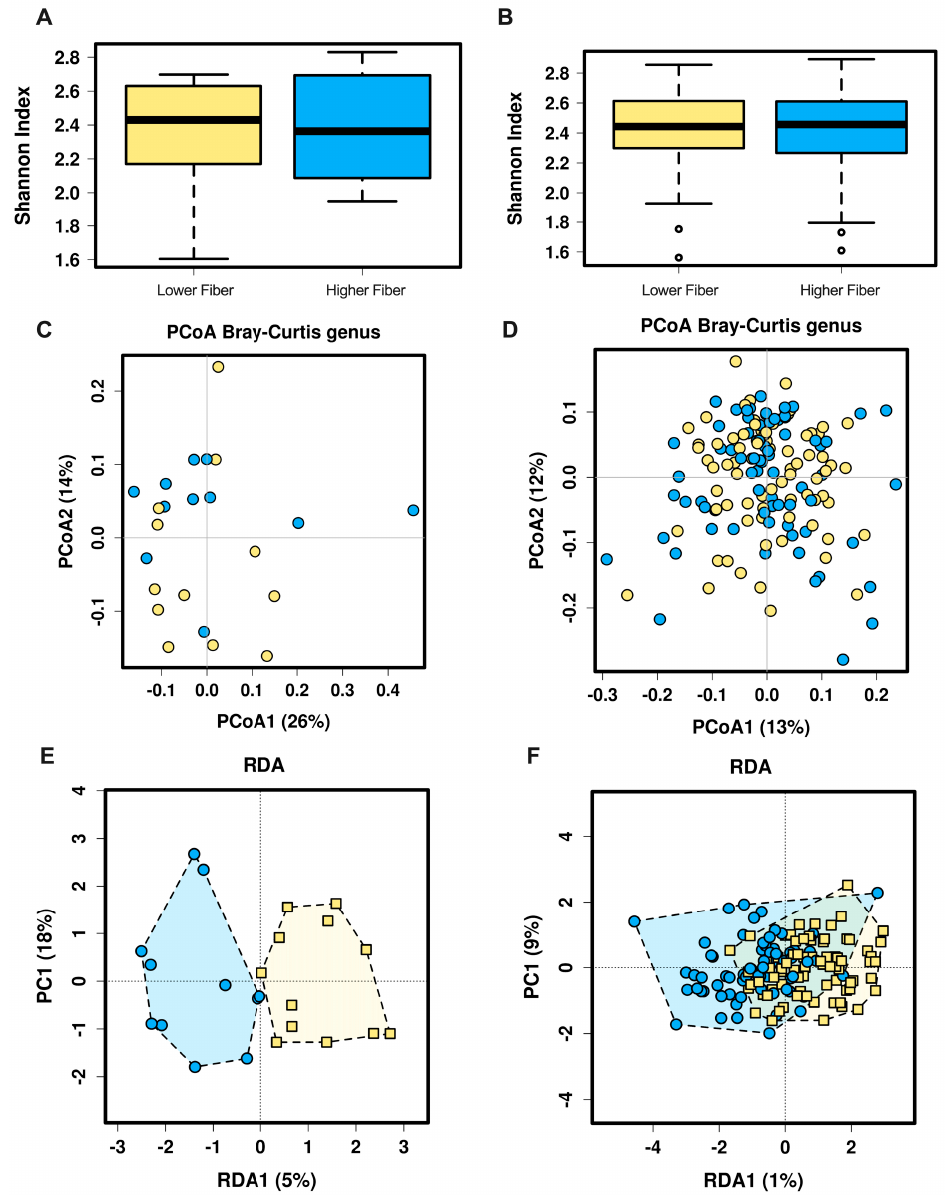
Figure 1. Alpha and beta diversity of the gut microbiota in women with HDP and NT. Alpha diversity as measured by the Shannon index in women with future HDP ( A ) and NT women ( B ). Beta diversity as measured by unsupervised hierarchical clustering by PCoA in women with HDP ( C ) and NT women ( D ). Beta diversity as measured by supervised hierarchical clustering by RDA in women with HDP ( E ) and NT women ( F ). Yellow symbols, lower fiber; blue symbols, higher fiber. HDP = Hypertensive disorders of pregnancy. NT =